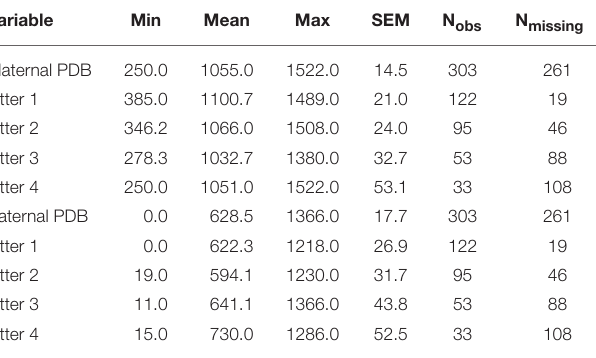
TABLE 1 | Descriptive statistics for pup-directed behaviors, number of litters observed, and number of litters left unobserved (of the 141 total observed pairs) across litters and by